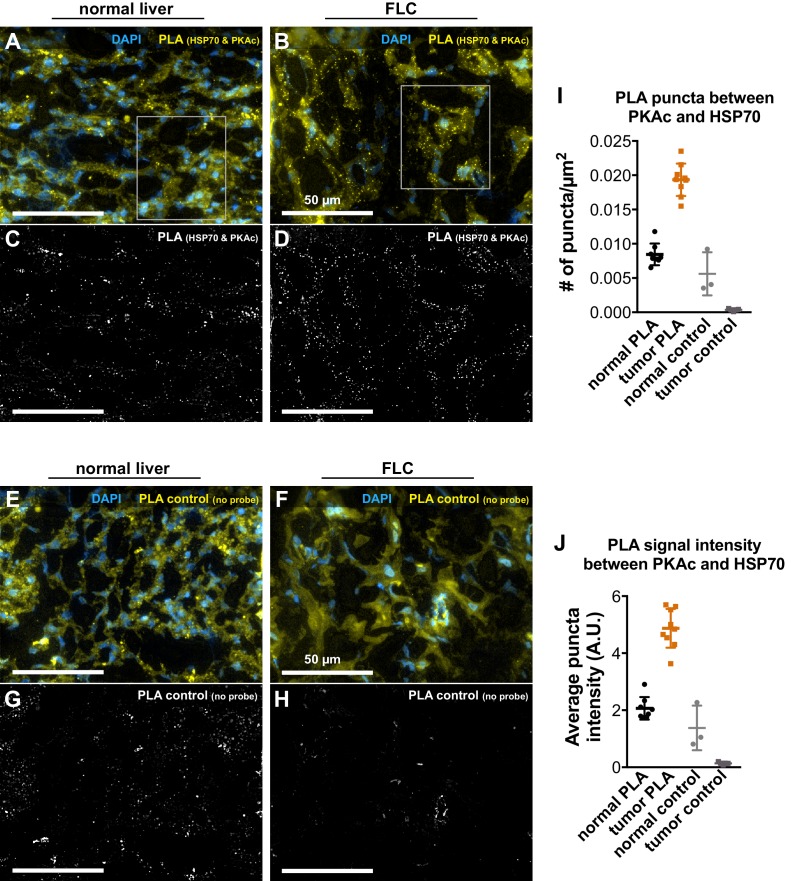
Additional Proximity Ligation (PLA) detection of Hsp70 and PKAc in patient tissue.(A and B) Full-size source images for Figure 1I & J, gray boxes indicate area shown. PLA signal between Hsp70 and PKAc (yellow) is less prominent in normal tissue (A) than in FLC (B). Dapi (blue) marks nuclei. (C and D) Images of the PLA signals in (A and B) after removing unfocused fluorescent signal with Keyence software haze reduction. (E and F) Control images for normal liver (E) and FLC (F) where PLA cannot occur due to omission of one secondary antibody. (G and H) Yellow channel signals of control normal liver (G) and FLC (H). Note greater background fluorescence in normal liver sections vs. FLC emanating from fat deposits. Scale bars are 50 µm. (I and J) Quantification of number of PLA puncta (I) and average puncta intensity (J). Data presented as mean ±s.d. with technical replicates as individual data points. Total areas quantified were. 349 mm2,. 392 mm2,. 131 mm2, and. 131 mm2, and total puncta measured were 2,943, 7,583, 733, and 47 for normal PLA, tumor PLA, normal control, and tumor control conditions, respectively.